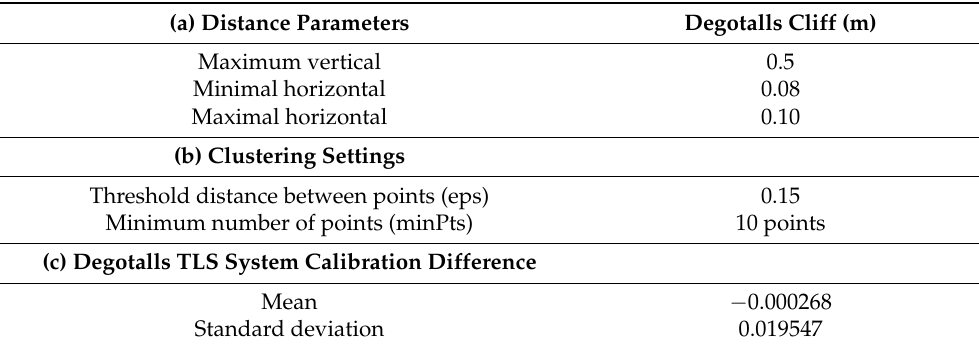
Table 6. Parameters to set the calibration and monitoring processes: ( a ) parameters used to define the geometry of the double truncated cone in the measure of the differences; ( b ) clustering parameters with the nomenclature equivalent to the DBSCAN algorithm; ( c ) mean and standard deviation to define the difference distribution for the TLS ILRIS-3D in both Degotalls areas for a mean range of 175 m.